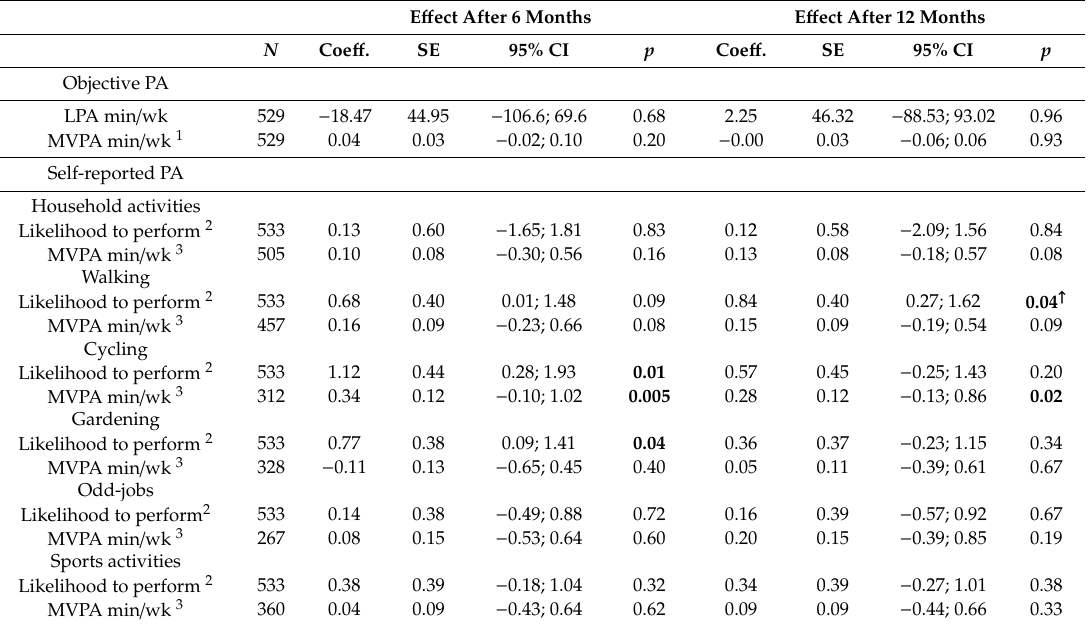
Table 3. Intervention e ff ects (Group × Time interaction) on PA outcomes for 6 and 12 months follow-up *. E ff ect After 6